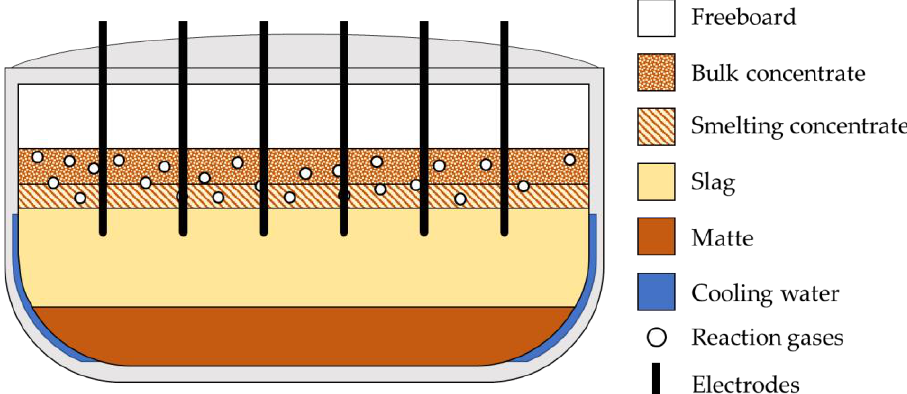
Figure 4. Submerged arc furnace model layout, with distinct bulk and smelting concentrate, liquid slag and matte, trapped reaction gas, cooling water, and freeboard zones. Each zone is modelled as a separate lumped parameter system.